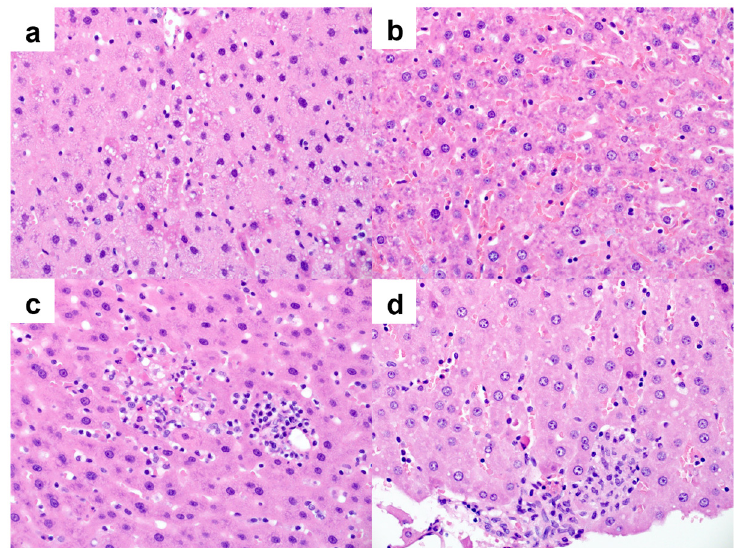
Figure 4. Photomicrographs taken from hepatic tissue of rats receiving GEF and ASP 175 or ASP 1000. ( a ) Mild cytoplasmic vacuolization of the hepatocytes and ( b ) sinusoidal congestion were noted in liver tissues from rats GEF and ASP 175 mg/kg and GEF and ASP 1000 mg/kg (hematoxylin and eosin, ×400 magnification). ( c ) Foci of spotty necrosis were noted in a single rat from GEF and ASP 175 mg/kg and ( d ) a non-necrotizing granuloma was noted in a rat from GEF and ASP 1000 mg/kg (hematoxylin and eosin, ×400 magnification).